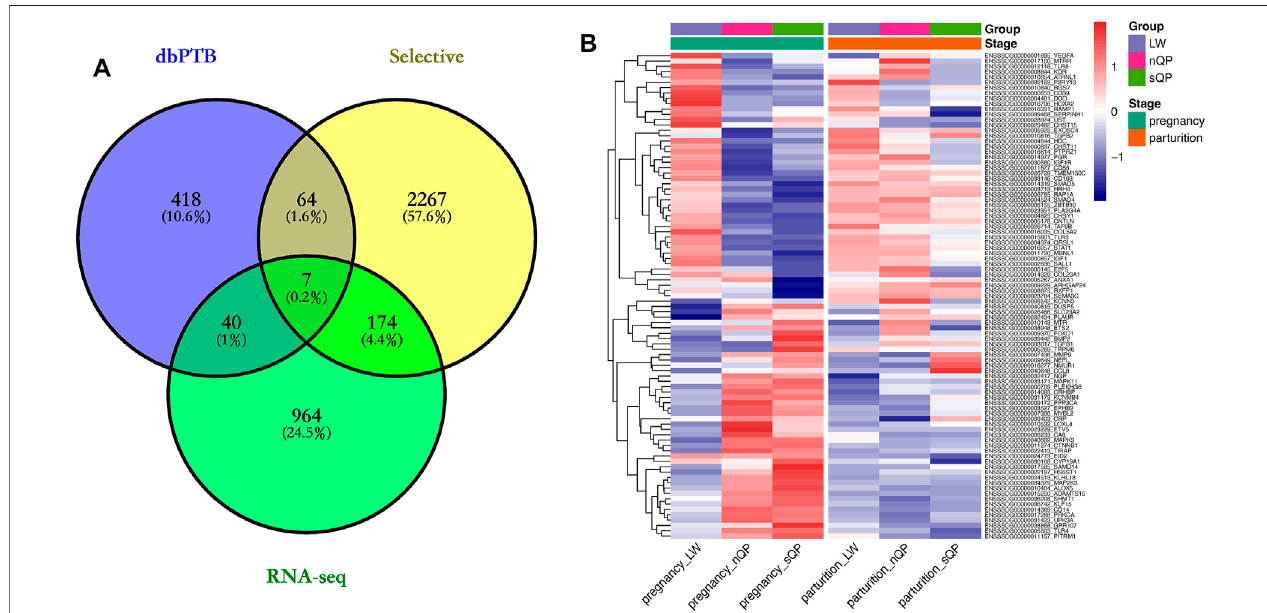
FIGURE4| Shortgestationlengthgenes. (A) VENNplotofselective,RNA-seqcandidategenes,anddbPTBgenes. (B) Expressionheatmapofcandidategenesin dbPTB.